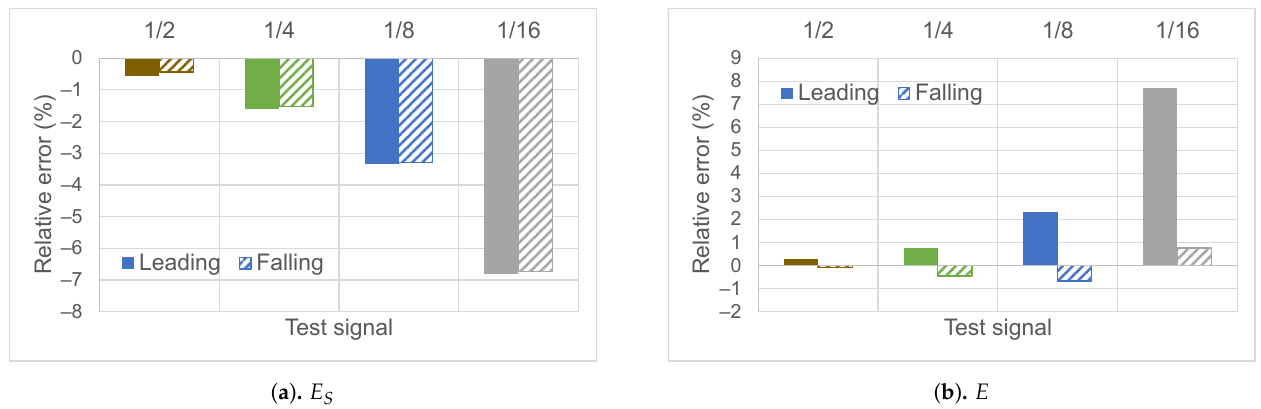
Figure 12. “Leading” and “falling” tests relative error: ( a ) total apparent energy E ; and ( b ) total active energy E .